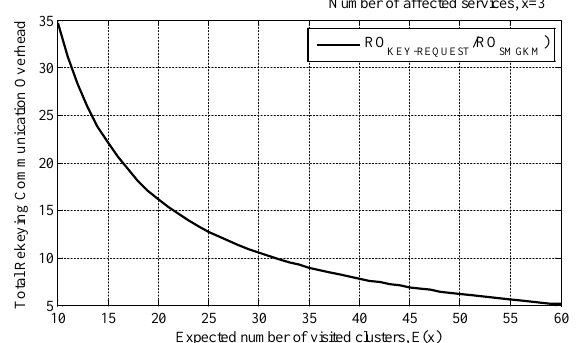
Figure 4. Relative communication overhead (the ratio RO Key_request to that of RO SMGKM